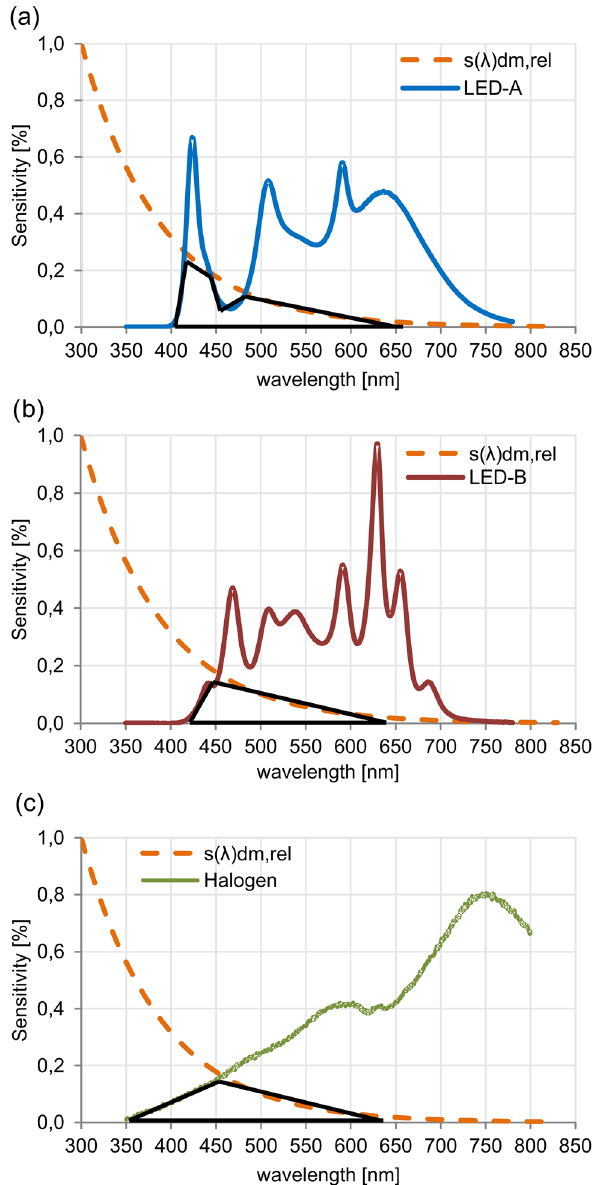
Figure 1. Harmful radiation content of the lightings depicted by the black triangle: ( a ) LED A (420 nm), ( b ) LED B (460 nm), and ( c ) halogen